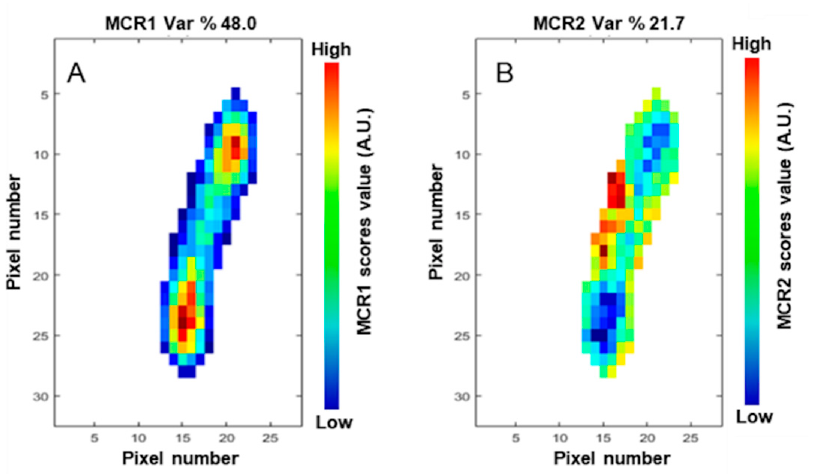
Figure 5. ( A ) Score plot of MCR1. The color scale is based on MCR1 intensity, from lowest ( blue ) to highest ( red ). ( B ) Score plot of MCR2. The color scale is based on MCR2 intensity, from lowest ( blue ) to highest ( red ).